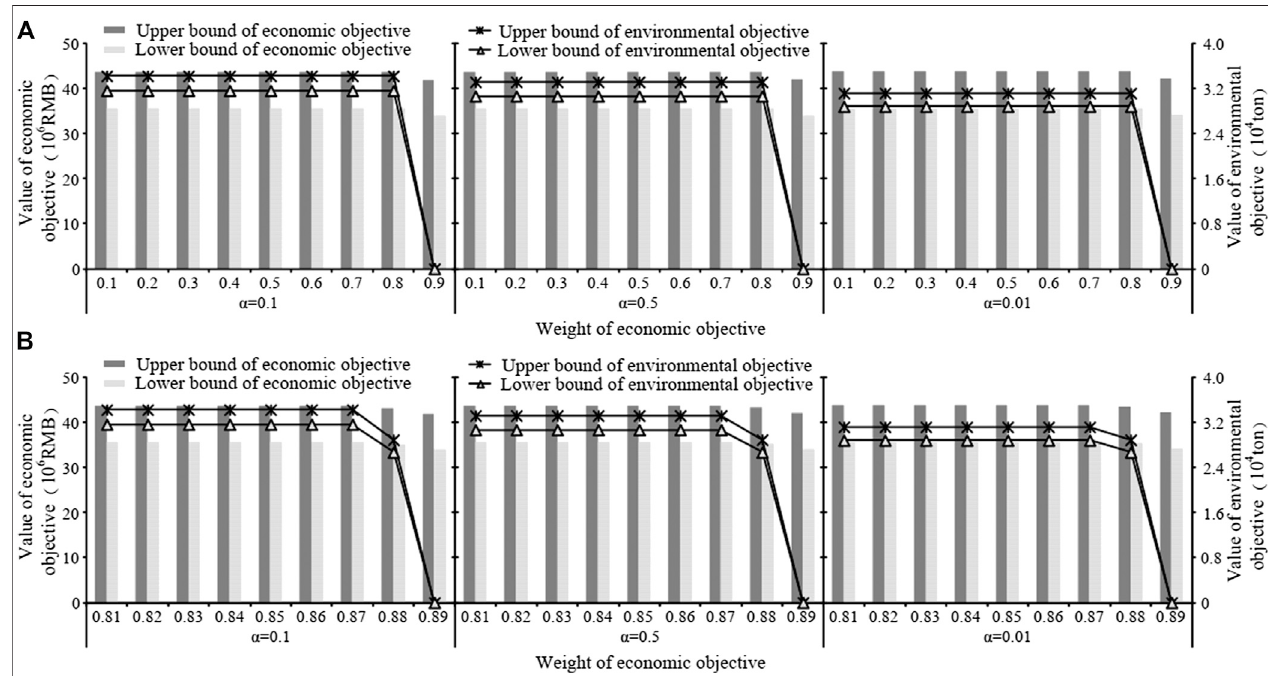
FIGURE 6 | Variations in the runoff and low-impact development projects areas under two climate change scenarios. (A) RCP 4.5 scenario; (B) RCP 8.5 scenario.